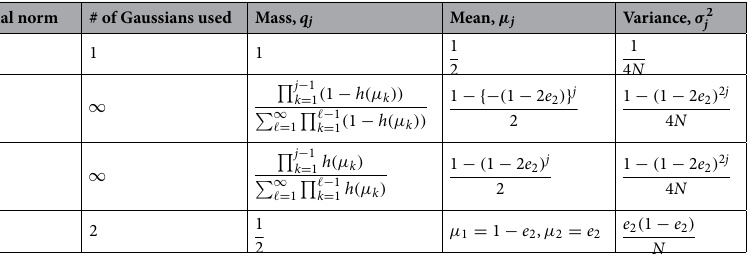
( 1 p ( 1 e 1 ) p ) e 1 (see Eq. (1)). We employ = − + −